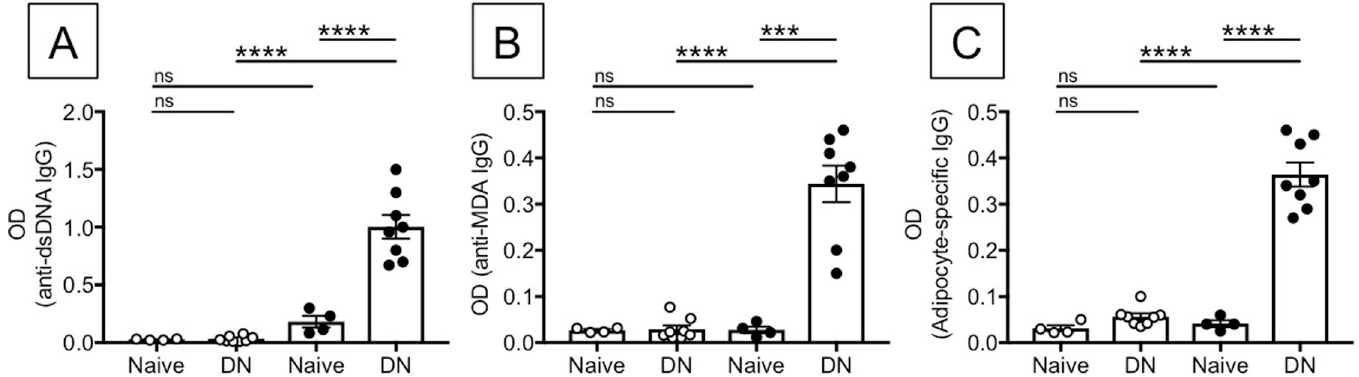
Fig 3. DN B cells make anti-self-specific autoimmune antibodies. Na ï ve and DN B cells were sorted from the peripheral blood of 4 young (white symbols) and 8 elderly (black symbols) individuals. Sorted cells were left unstimulated for 10 days to evaluate by ELISA the presence of anti-dsDNA antibodies ( A ), anti-MDA antibodies ( B ), and anti-SAT antibodies ( C ) in culture supernatants. Mean comparisons between groups were performed by one-way ANOVA. ��� p < 0.001, ���� p < 0.0001, ns: not significant.